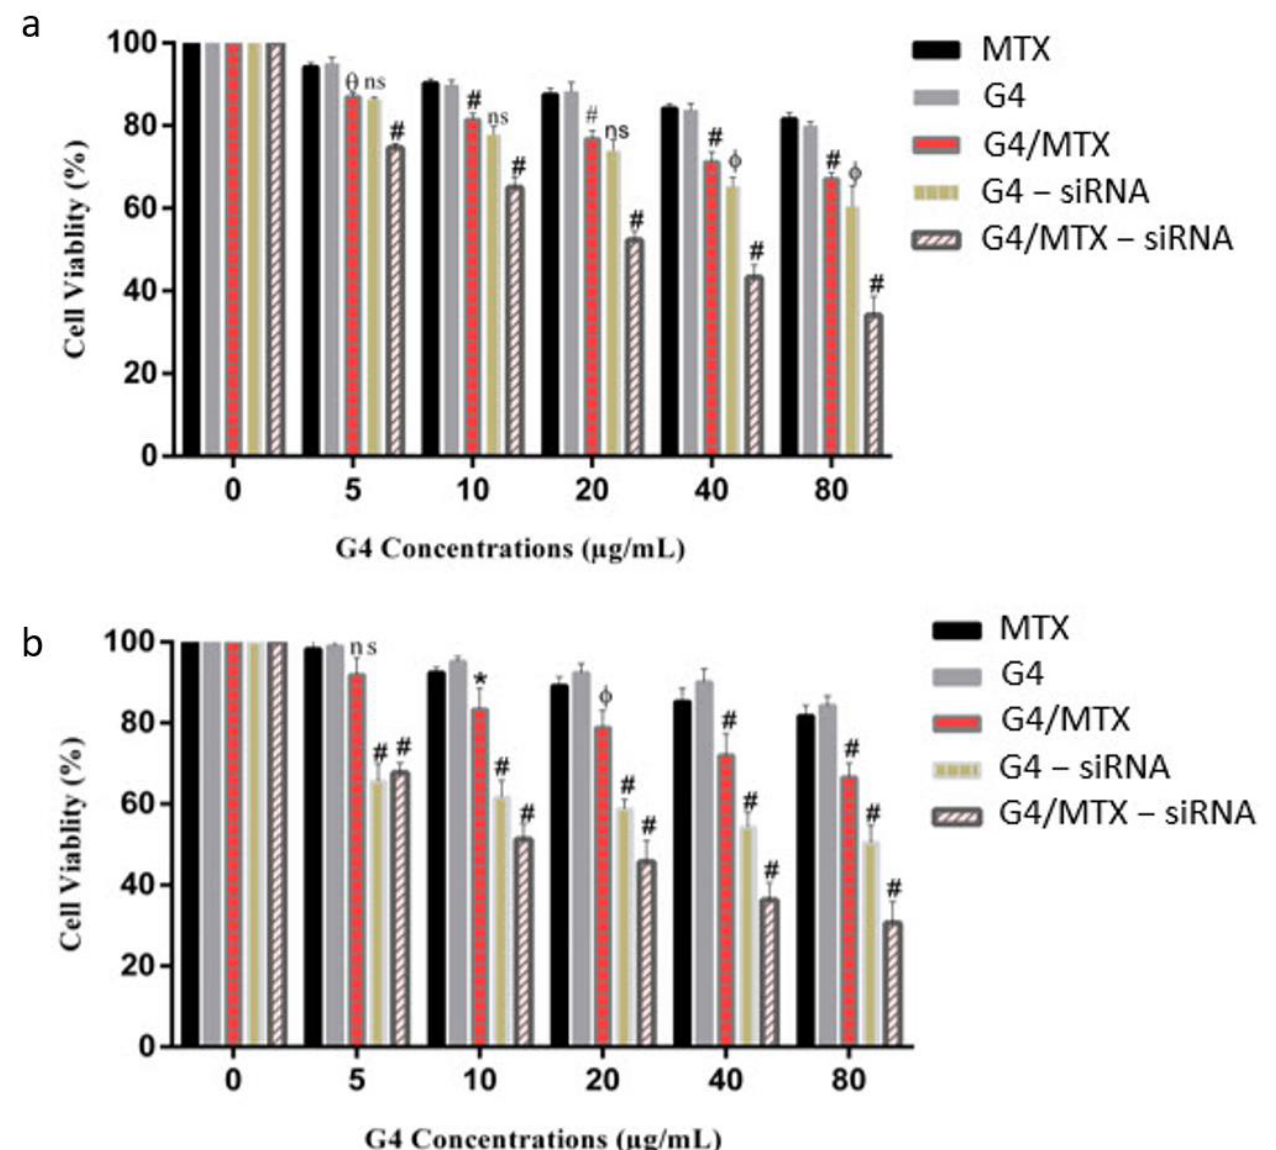
Figure 5. Viability of MCF-7 ( a ) and NDA-MB-231 ( b ) cancer cells after treatment with MTX, G4, G4/MTX, G4-siRNA and G4/MTX-siRNA nanocomplex (at siRNA concentrations 0–200 nM) for 48 h. Error bars displays standard deviations (SD) and the data are expressed mean ± SD ( n = 3). (non-significant (ns), * p value < 0.05, φ p value < 0.005, Θ p value < 0.0006 and # p value < 0.0001). Note: in both cells G4/MTX result was compared with MTX, while G4-siRNA and G4/MTX-siRNA were compared with G/MTX nanosystem.